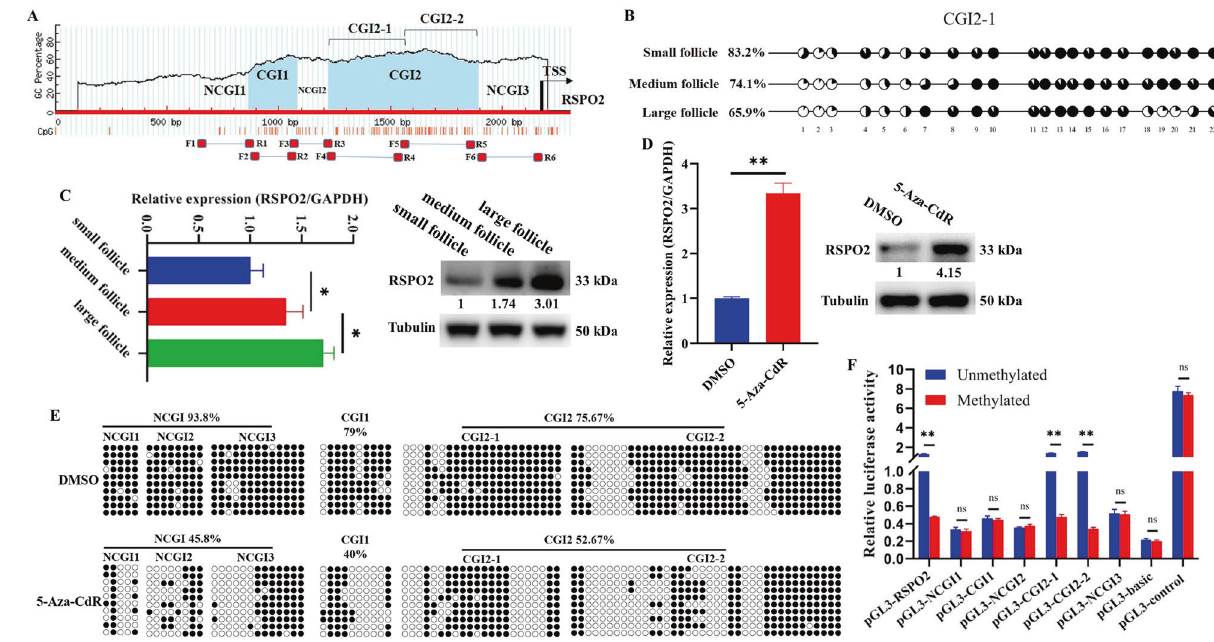
Fig. 1 DNA hypomethylation in the CGI2-1 region of RSPO2 promoter might promote the expression level of RSPO2 during follicular development. A Schematic distribution of the CpG islands and bisul fi te sequencing primers in the promoter of RSPO2 . Blue region is the CpG island; red and horizontal bars show the positions of bisul fi te primers. B Bisul fi te sequencing was conducted to determine the methylation status of CGI2-1 at the RSPO2 promoter in small (1 – 3 mm), medium (3 – 5 mm), and large (5 – 7 mm) follicles. C The mRNA and protein expression level of RSPO2 in small, medium, and large follicles. D The mRNA and protein expression level of RSPO2 in porcine GCs treated with 5-Aza-CdR. The numbers below bands were folds of band intensities relative to control. The band intensities were measured by ImageJ and normalized to Tubulin. E BSP was used to detect the NCGI and CGI methylation status of RSPO2 in porcine GCs treated with 5-Aza-CdR. F The luciferase reporter plasmids carrying different regions of RSPO2 were methylated in vitro and transfected into GCs. Relative luciferase activity in GCs were determined. * P < 0.05, ** P < 0.01. CGI CpG island, NCGI non-CpG